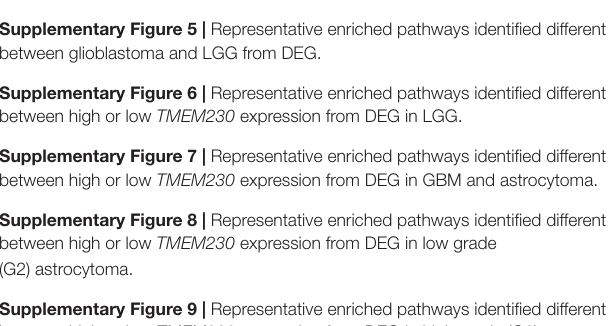
Supplementary Figure 3 | Representative enriched pathways identified different between high or low TMEM230 expression from differentially expressed genes (DEG) in patient samples of astrocytoma. Supplementary Figure 4 | Representative enriched pathways identified different between high or low TMEM230 expression from differentially expressed genes (DEG) in patient samples of glioblastoma. Supplementary Figure 5 | Representative enriched pathways identified different between glioblastoma and LGG from DEG. Supplementary Figure 6 | Representative enriched pathways identified different between high or low TMEM230 expression from DEG in LGG. Supplementary Figure 7 | Representative enriched pathways identified different between high or low TMEM230 expression from DEG in GBM and astrocytoma. Supplementary Figure 8 | Representative enriched pathways identified different between high or low TMEM230 expression from DEG in low grade (G2) astrocytoma. Supplementary Figure 9 | Representative enriched pathways identified different between high or low TMEM230 expression from DEG in high grade (G3) astrocytoma. Supplementary Figure 10 | Protein validation of TMEM230 candidate responding genes in U87-MG. (A) Western blot analysis for SYNDECAN-1, CD44, and MOESIN proteins in U87 control cells (U87shSCR) and in U87 cells in which TMEM230 was down regulated (U87shTMEM230). Endogenous control: β -ACTIN. (B) Immunofluorescence analysis for CAVEOLIN-1 and ACTIN through phalloidin interaction in U87 control and shTMEM230 transduced cells (GFP staining). Nuclei are visualized with DAPI. That TMEM230 may have a role in actin polymerization and cytoskeleton regulation is supported by immunofluorescence staining of PHALLOIDIN showing that U87 cells in which TMEM230 was downregulated was associated with decrease in the number and quality in the long multistrand structures of actin. (C) Immunofluorescence analysis for FIBRONECTIN in U87 control and shTMEM230 transduced cells (GFP staining). Nuclei are visualized with DAPI. Expression analysis of patient samples suggests that Fibronectin is differentially expressed between gliomas and non-malignant glial cells. Immunofluorescence analysis supports that FIBRONECTIN is not differentially expressed in U87 control and shTMEM230 transduced cells, and therefore TMEM230 does not regulate FIBRONECTIN expression. Supplementary Figure 11 | TMEM230 expression in diverse cell types from non-malignant and malignant human brain. (A) Distribution of TMEM230 transcripts in different non-malignant cell populations from human brain according to the study of Darmanis (2015) (Accession: GSE67835, survey of human brain transcriptome diversity at the single cell level). Candidate cell populations were identified representative of the major neuronal, glial and vascular cell types according to published candidate gene markers. The distribution is represented by a boxplot with a minimum, the first quartile, the sample median, the third quartile and the maximum of the expression for each cell population, from the bottom to the top. The distribution profiles support that TMEM230 is expressed in most non-malignant cells at relatively equal but low levels. (B–D) Expression analysis of Tmem230 from Single-Cell Rna-Seq Analysis of Infiltrating Neoplastic Cells at the Migrating Front of Human Glioblastoma. (B) 2D-tSne representation of all single cells included from the study of Darmanis (2017) with a sample size of n = 3,589. Cell clusters are differentially colored and identified as distinct cell classes. (C) Expression of characteristic cell-type-specific genes overlaid on the 2D-tSne space. (D) Quantification of Tmem230-positive cells of distinct cell classes. Supplementary Table1 | Patient clinical features include gender, age, tumor size in cm 3 and TMEM230 expression level. Supplementary Table 2 | All enriched pathways identified different between high or low TMEM230 from differentially expressed genes (DEG) in patient samples of oligodendrogliomas A). Supplementary Table 4 | All enriched pathways identified different between high or low TMEM230 expression in astrocytoma of patients from